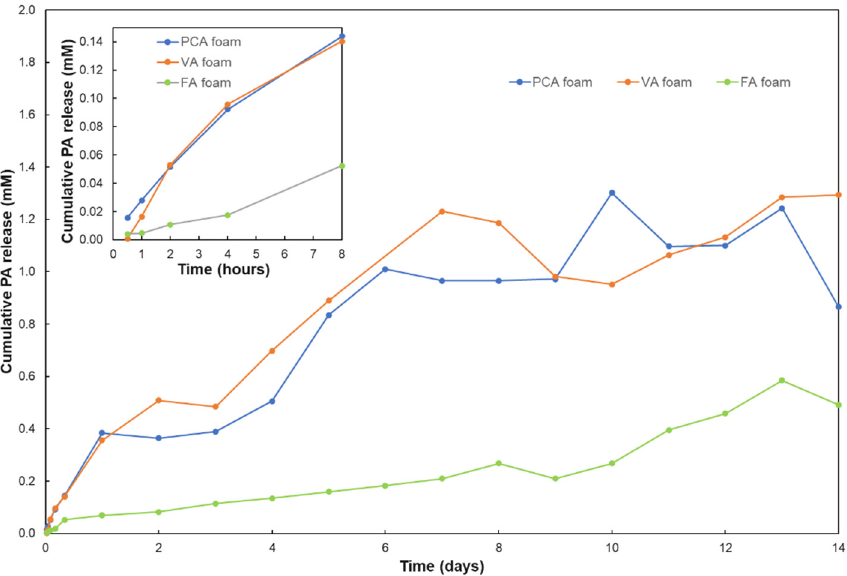
Figure 5. Analysis of cumulative PA release from SMP foams in PBS over 14 days. PA concentrations were determined using ultraviolet–visible (UV–Vis) spectrophotometry.